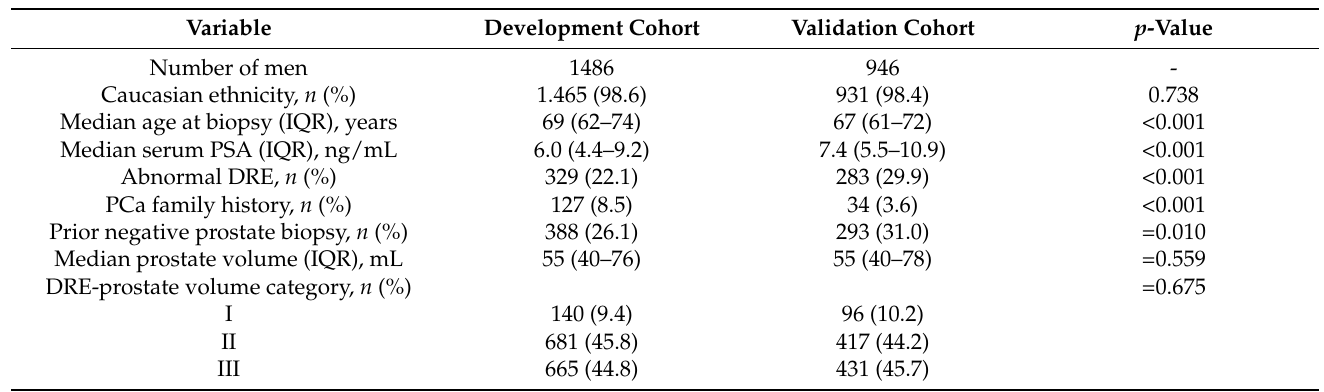
Table 1. Characteristics of men making up the development and validation